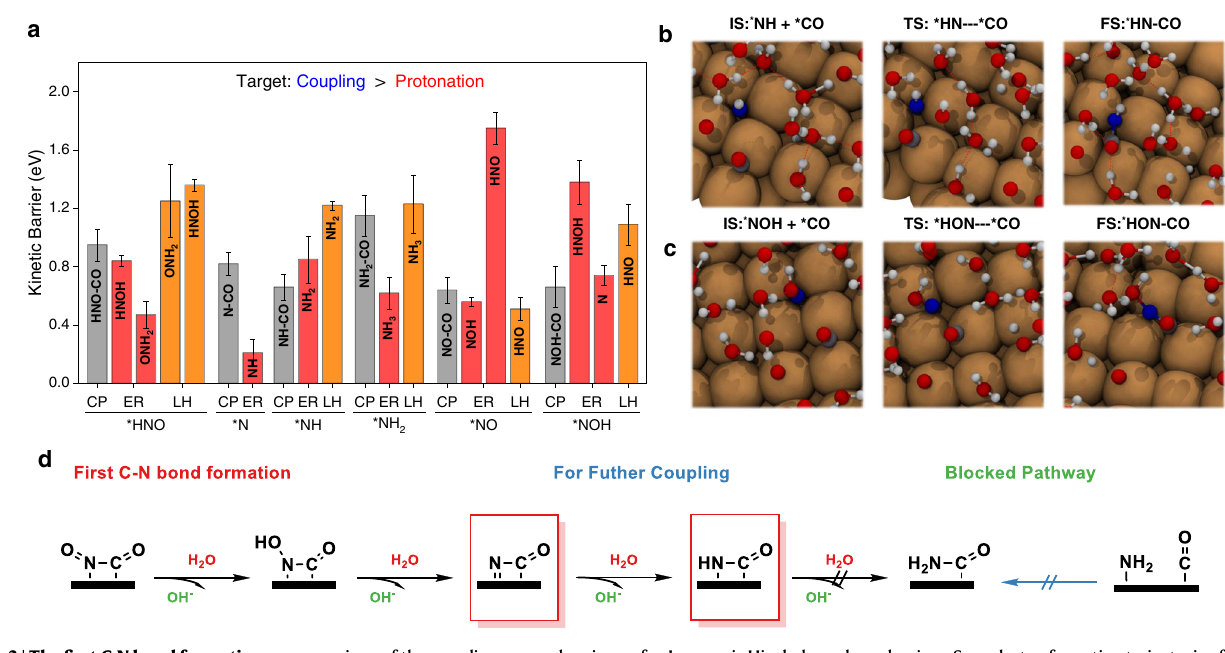
for Langmuir-Hinshelwood mechanism. Snapshots of reactive trajectories for the * CO coupling with b , * NO, c , * NOH. d Schematic diagram for the formation of the fi rst C-N bond as well as subsequent